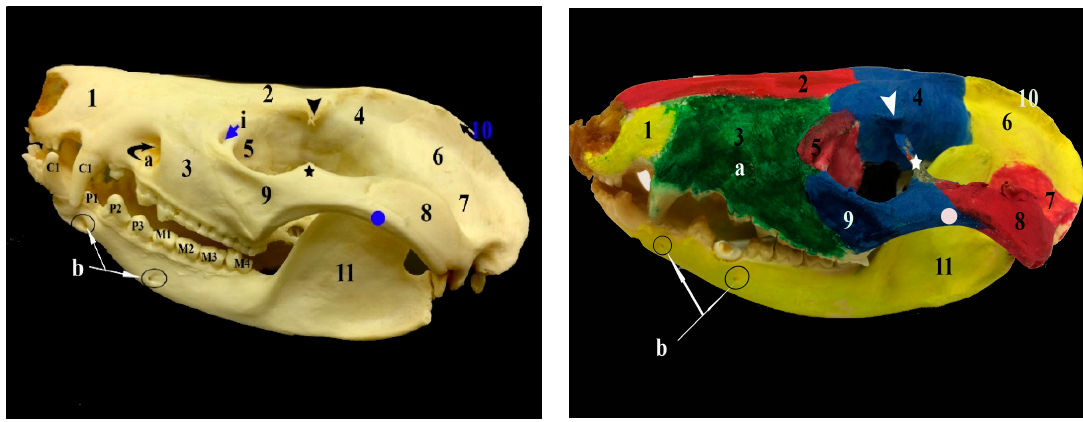
Figure 1. Photograph showing the lateral view of the skull and mandible of the common opossum. 1. premaxilla bone; 2. nasal bone; 3. maxilla bone; 4. frontal bone; 5. lacrimal bone; 6. parietal bone; 7. squamosal bone; 8. zygomatic process of squamosal bone; 9. zygomatic bone; 10. external sagittal crest; 11. mandible; arrow head: postorbital process of frontal bone; star: frontal process of zygomatic bone; circle: temporal process of zygomatic bone; a. infraorbital foramen; b. mental foramina; C1. canine teeth; P1–3. premolar teeth; and, M1–4. molar teeth.